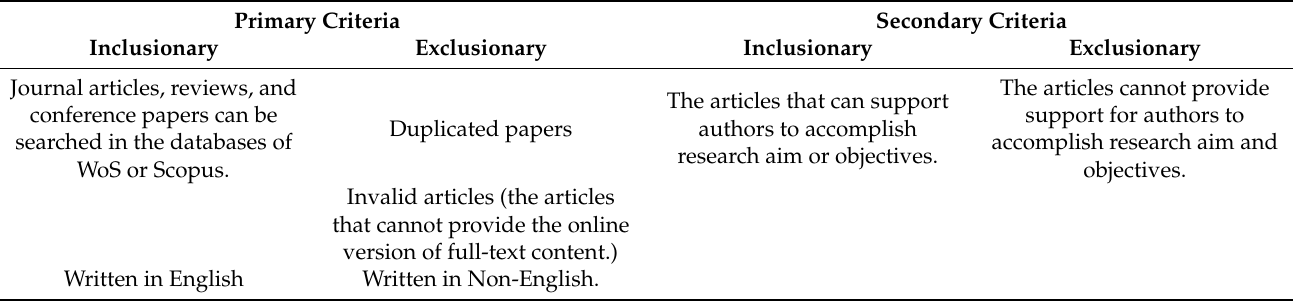
Table 1. Inclusion criteria and exclusion